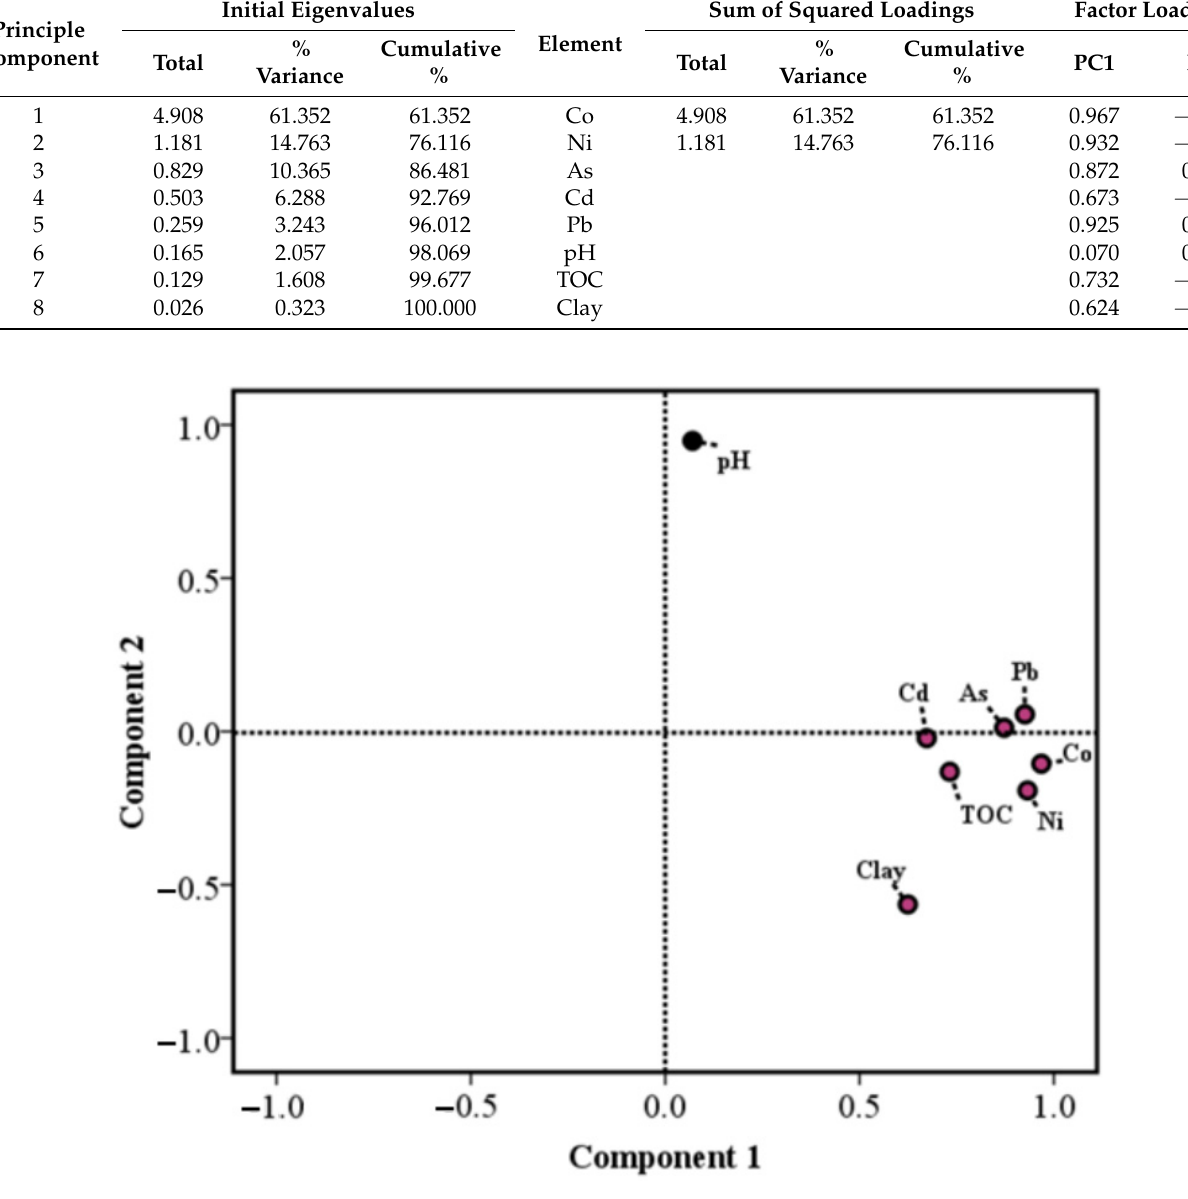
Figure 2. Factor analysis loading plot for S. alterniflora wetland in the Yellow River Delta. Table 4. Variances and rotated component matrices of heavy metals and physicochemical parame ‐ ters in sediments.